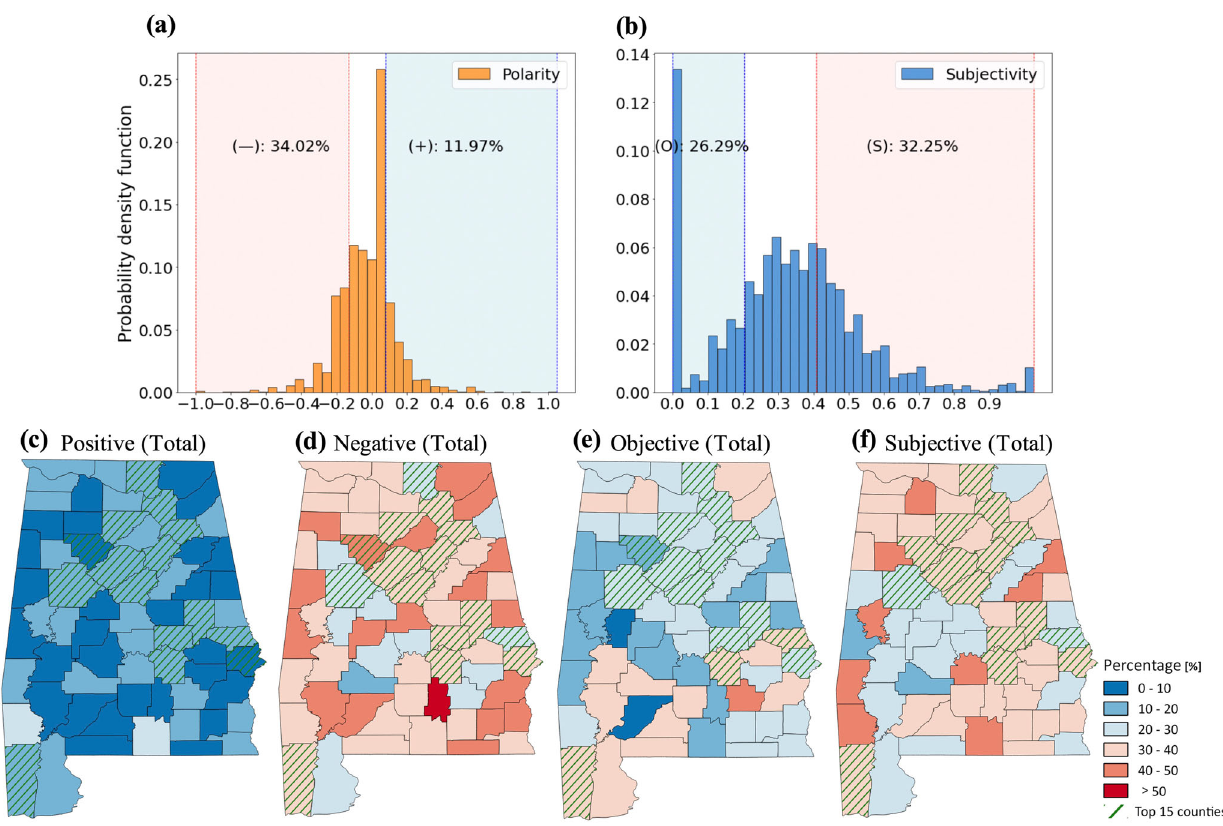
Fig. 2 Spatial patterns of the sentiment of water pollution complaints over 2012 – 2021. Probability mass functions of a polarity and b subjectivity scores. The percentages of positive ( + ), negative ( − ), objective (O), and subjective (S) complaints are shown in the text. County- level maps of the percentages of positive ( c ), negative ( d ), objective ( e ), and subjective ( f ) complaints. Green-colored hatch counties depict the top 15 counties in Alabama in terms of GDP in